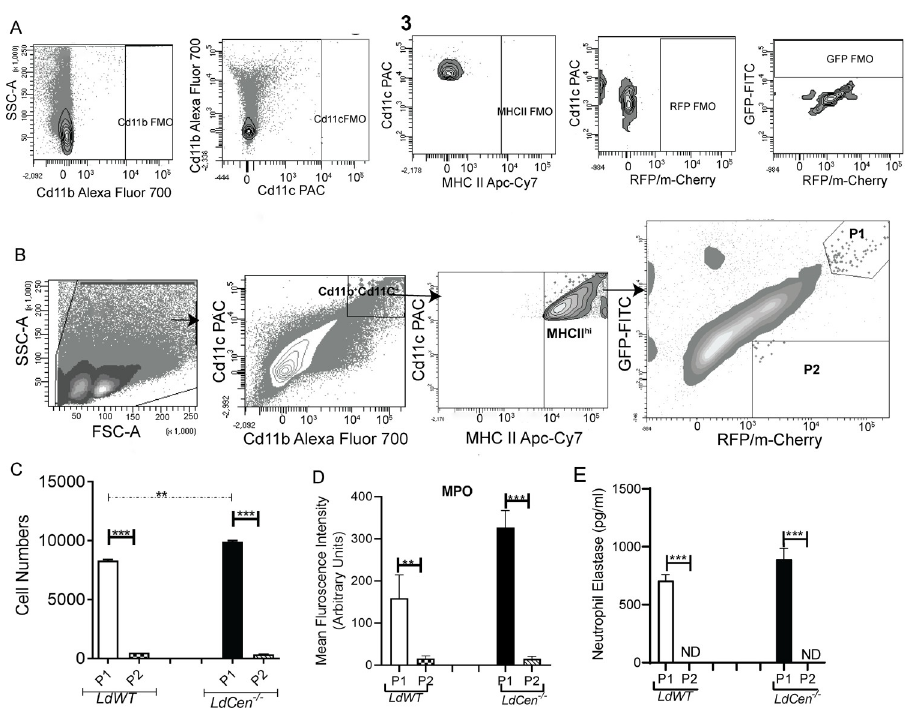
Fig 3. Dendritic cells in ear dLN predominantly become infected by phagocytosing infected neutrophils 5d post infection and express neutrophil markers. (A) The FMO’s for all the fluorophores used in (B) have been shown and are based on the same gating as in (B). (B) Cd11b + Cd11c + MHCII hi GFP hi RFP + (P1) and Cd11b + Cd11c + MHCII hi GFP - RFP + (P2) dendritic cells were flow sorted from the ear dLN of LYS-eGFP mice 5d post infection with either LdWT or LdCen -/- parasites. The sorting strategy has been displayed (n = 6). (C) Changes in the total number of P1 and P2 DCs per ear dLN. Values shown are the mean numbers of cells per ear dLN ± SD of results. 6 ear dLN, pooled data from 3 independent experiments that all yielded similar results (n = 6). � p < 0.05 (D) Mean fluorescence intensity of MPO in P1 and P2 DCs sort selected from infected LYS-eGFP mice 5d post infection. (E) The sort selected P1 and P2 DC population were assayed for NE activity as described in Materials and Methods. The NE activity was expressed as the absorbance observed at 450 nm. Data are pooled from three independent repeats and are shown as means ± SD that all yielded similar results (n = 6). ��� p < 0.0005 between the